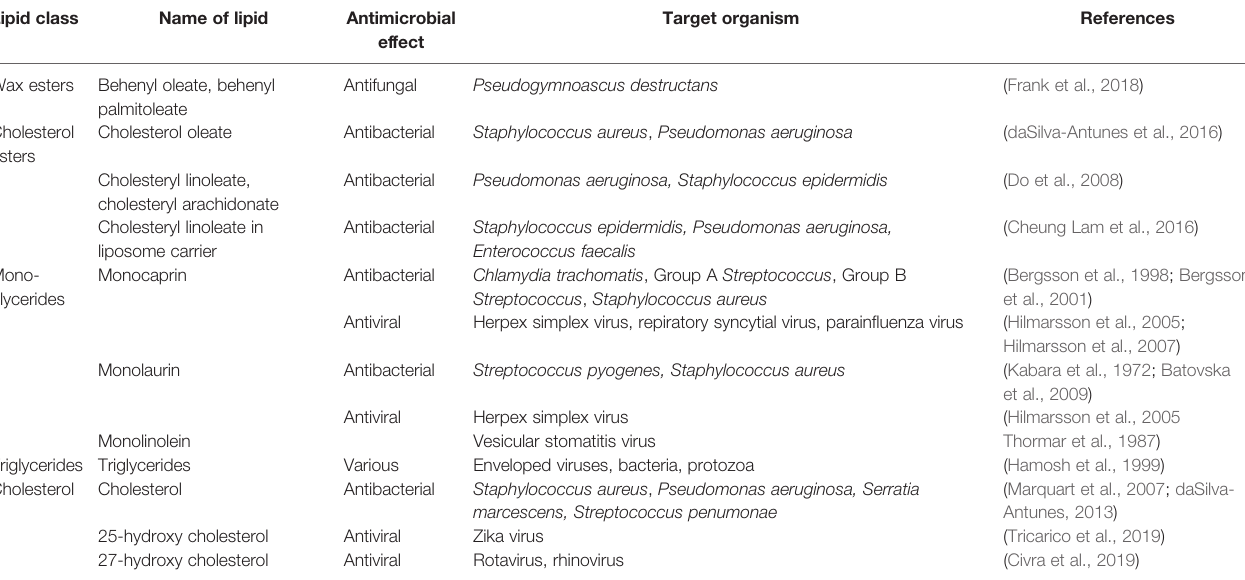
TABLE 2.1 | Antimicrobial potential of lipid classes in tears (wax esters, cholesterol esters, mono- and triglycerides, and cholesterol). Lipid